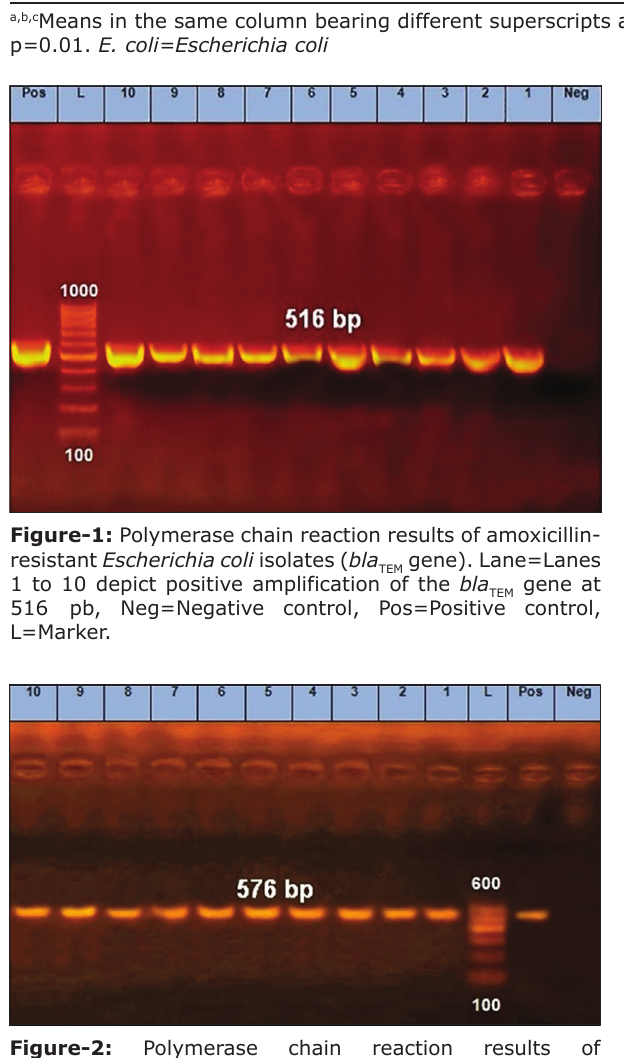
Figure-2: Polymerase chain reaction results of oxytetracycline-resistant Escherichia coli isolates ( tetA (A) gene). Lane=Lanes 1 to 10 depict positive amplification of the tetA (A) gene at 576 bp, Neg=Negative control, Pos=Positive control, L=Marker.